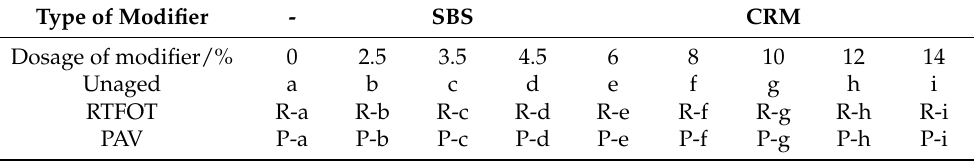
Table 4. Character number of test